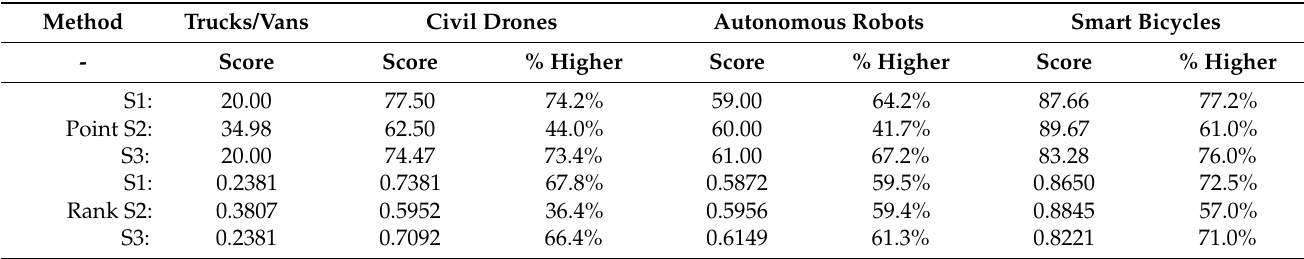
Table 16. Total scores for